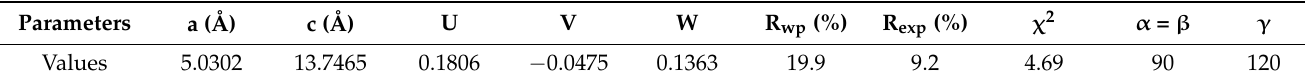
Figure 3. ( a ) Rietveld refinement of XRD spectra (inset: possible crystal structure of hexagonal IONPs). ( b ) Raman spectra of IONPs. Table 1. Refinement structural parameters and agreement factors for IONPs at room temperature with space group R3C.